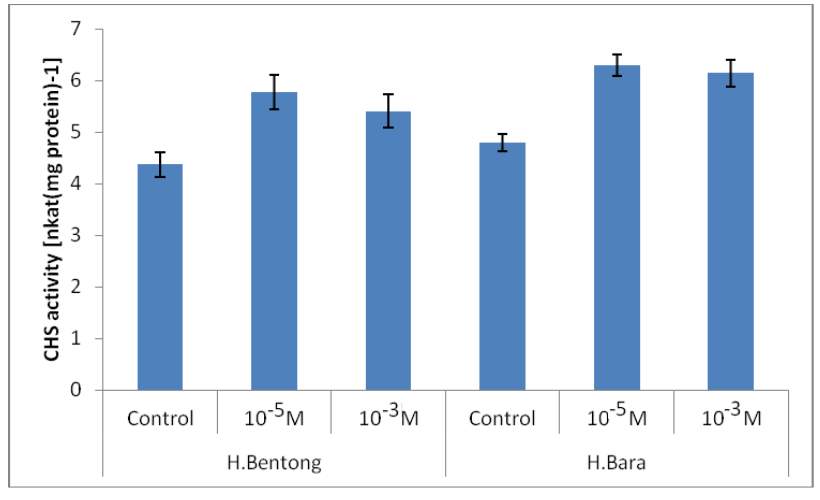
Figure 2. Chalcone synthase enzyme (CHS) activity in two ginger varieties treated with different concentration of salicylic acid (SA). Error bar represents standard error of